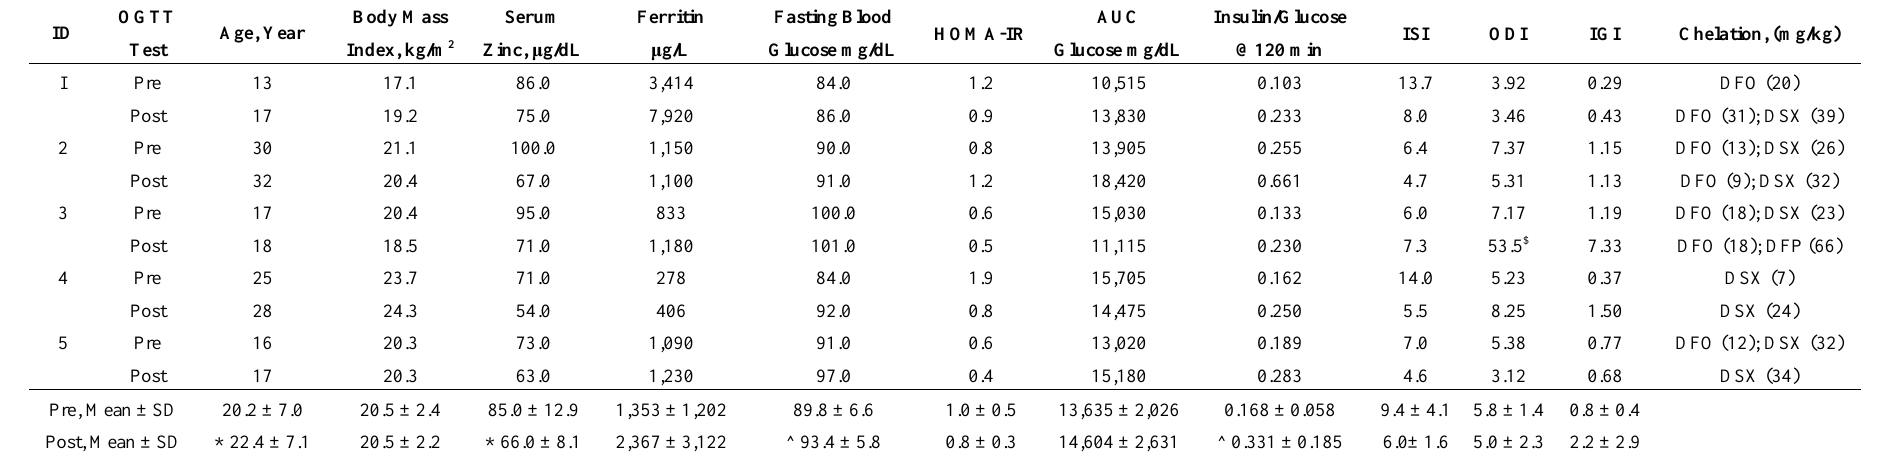
Table 2. Clinical data in five patients with transfusion dependent Thalassemia with repeat oral glucose tolerance test and serum zinc